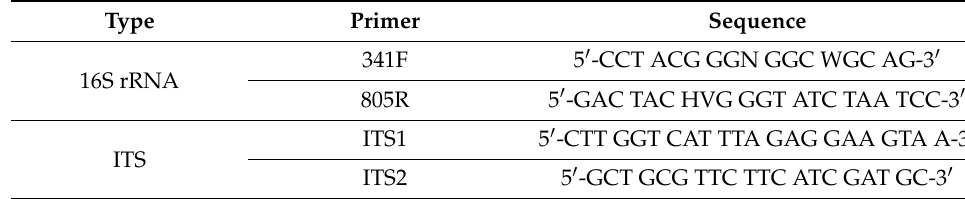
Table 2. The primers used for the 16S rRNA gene and ITS region in this